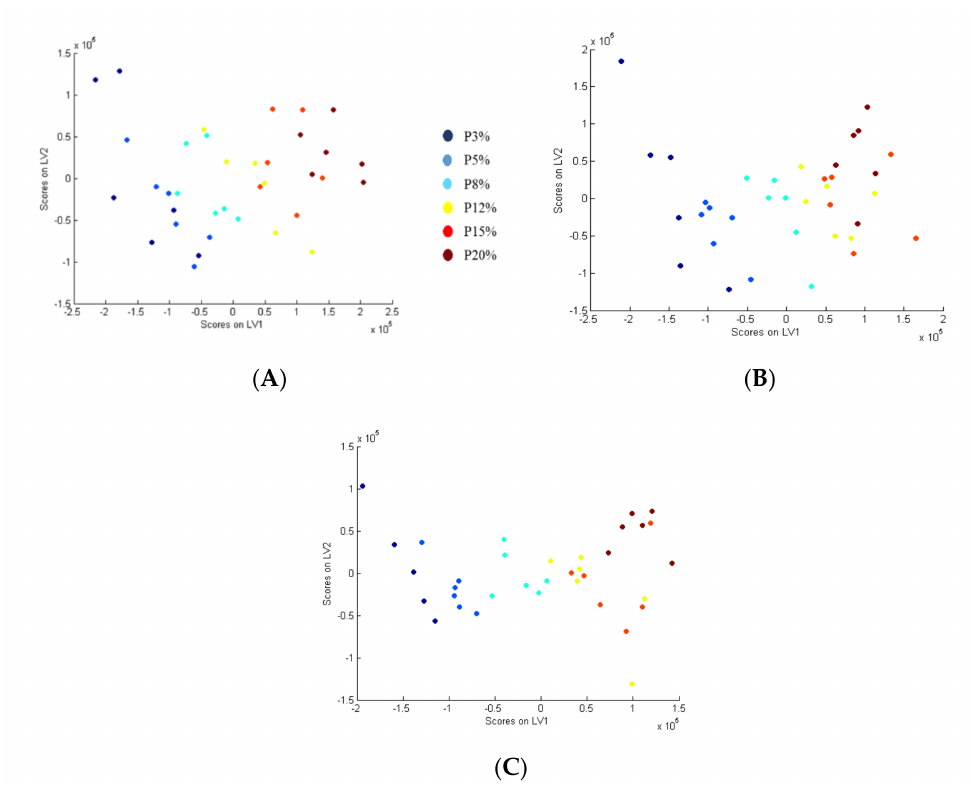
Figure 2. PLS Analysis for the data obtained by LC-MS characterizing the discrimination of the predefined groups to discriminate protein content diet based on IC1 and IC2 in urine ( A ), portal vein ( B ), and vena cava ( C